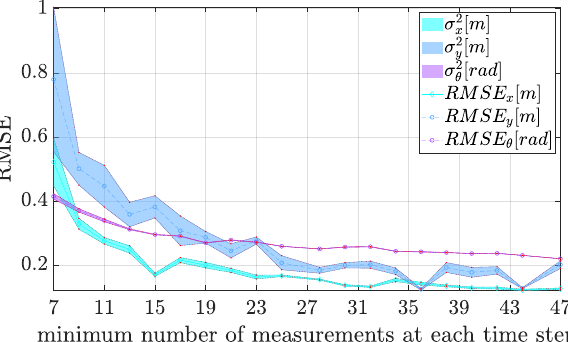
Figure 15. Impact of minimum number of available phase measurements at each time step on the localisation accuracy for the current experimental